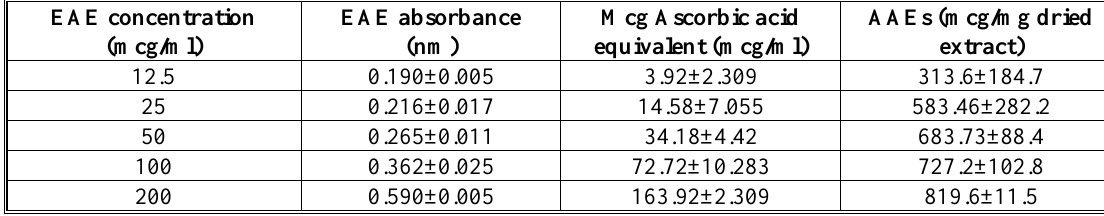
Table 4. The antioxidant activity measured by the FRAP method.